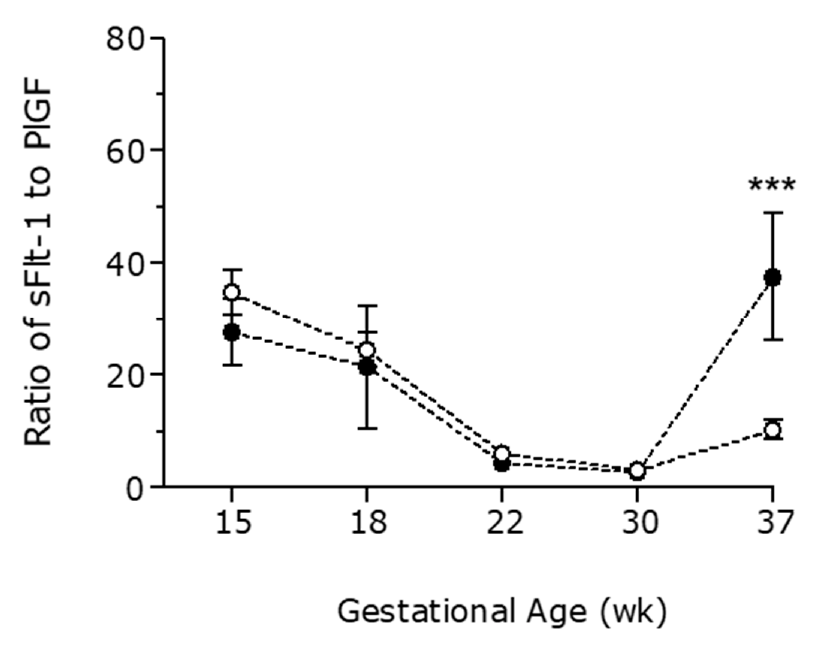
Figure 3. Ratio of sFlt-1 to PlGF in the control group (white points) and pregnant women affected by breast cancer (black points). Differences were analyzed by two-way analysis of variance. Data are presented as mean with SEM. ***, p < 0.001.